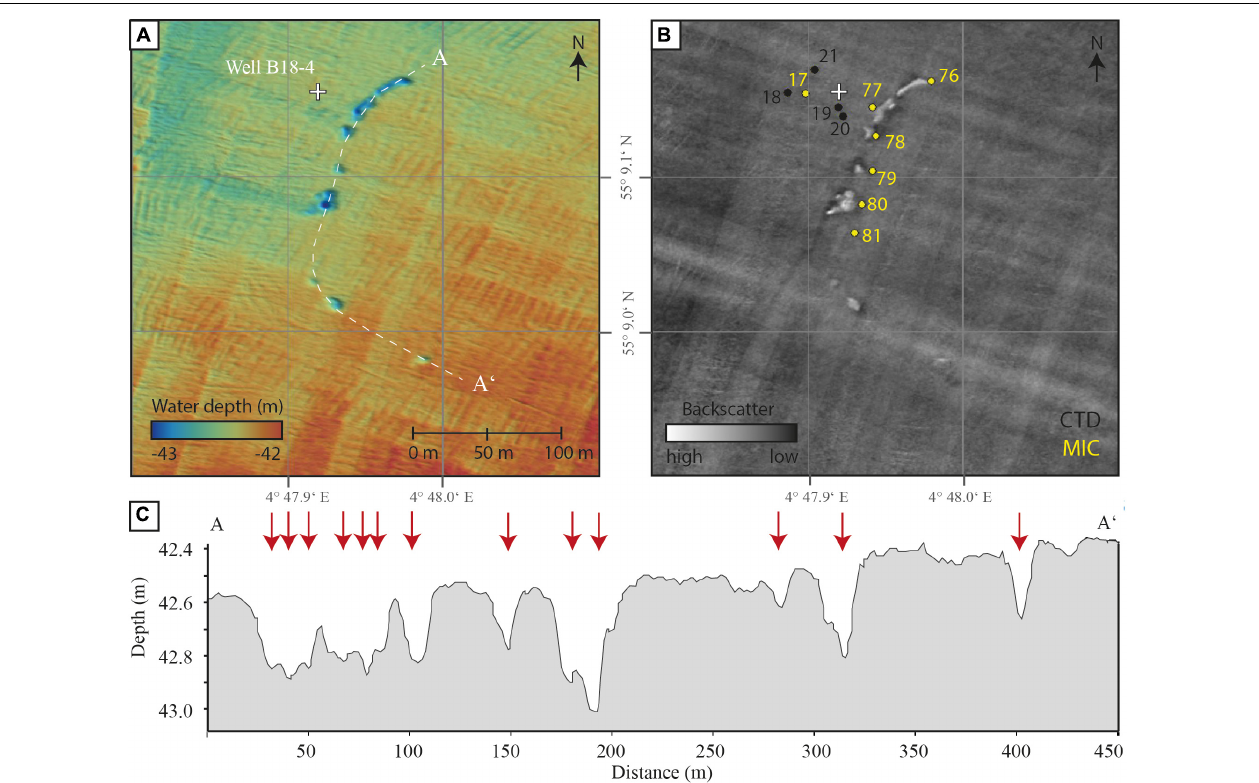
FIGURE 3 | (A) Bathymetric map of the area at salt diapir Britta, where several depressions were detected. Grid cell size is 2 m. Note: linear features in cm-scale vertically are artifacts. (B) The backscatter map shows that depressions are characterized by high backscatter signals (white patches). The area around well B18–4 and the depressions have been sampled for water (CTD casts) and bottom water (MIC stations) with station numbers ( Supplementary Table 2 ). (C) Bathymetric profile crossing the depressions (marked by red arrows) from A to A’ (A) , indicating their sizes, depths, and shapes.